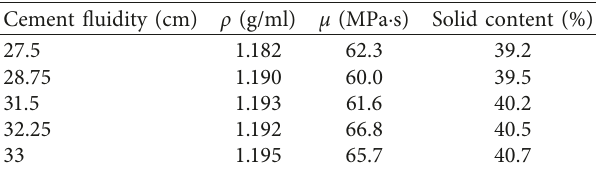
Table 3: Changes of density, viscosity, and solid content along with the variation in cement fluidity using the PCS produced with wheat straw.